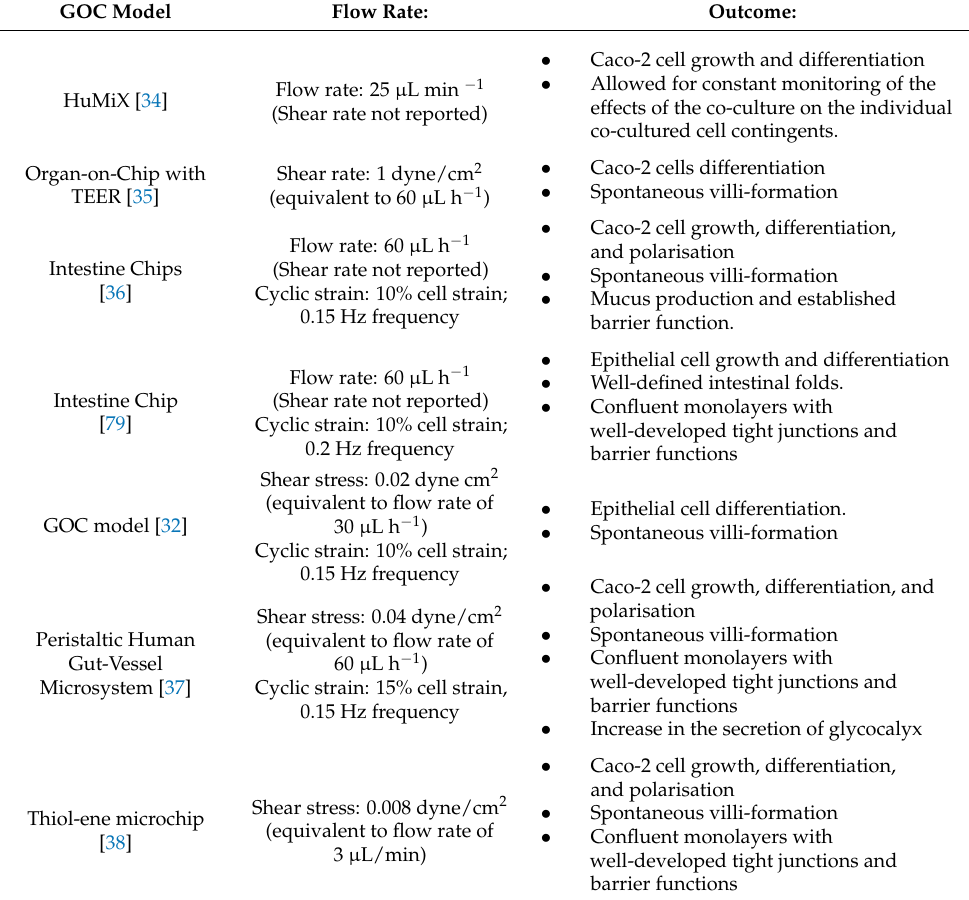
Table 3. Effect of dynamic fluid flow on different GOC models and respective cell